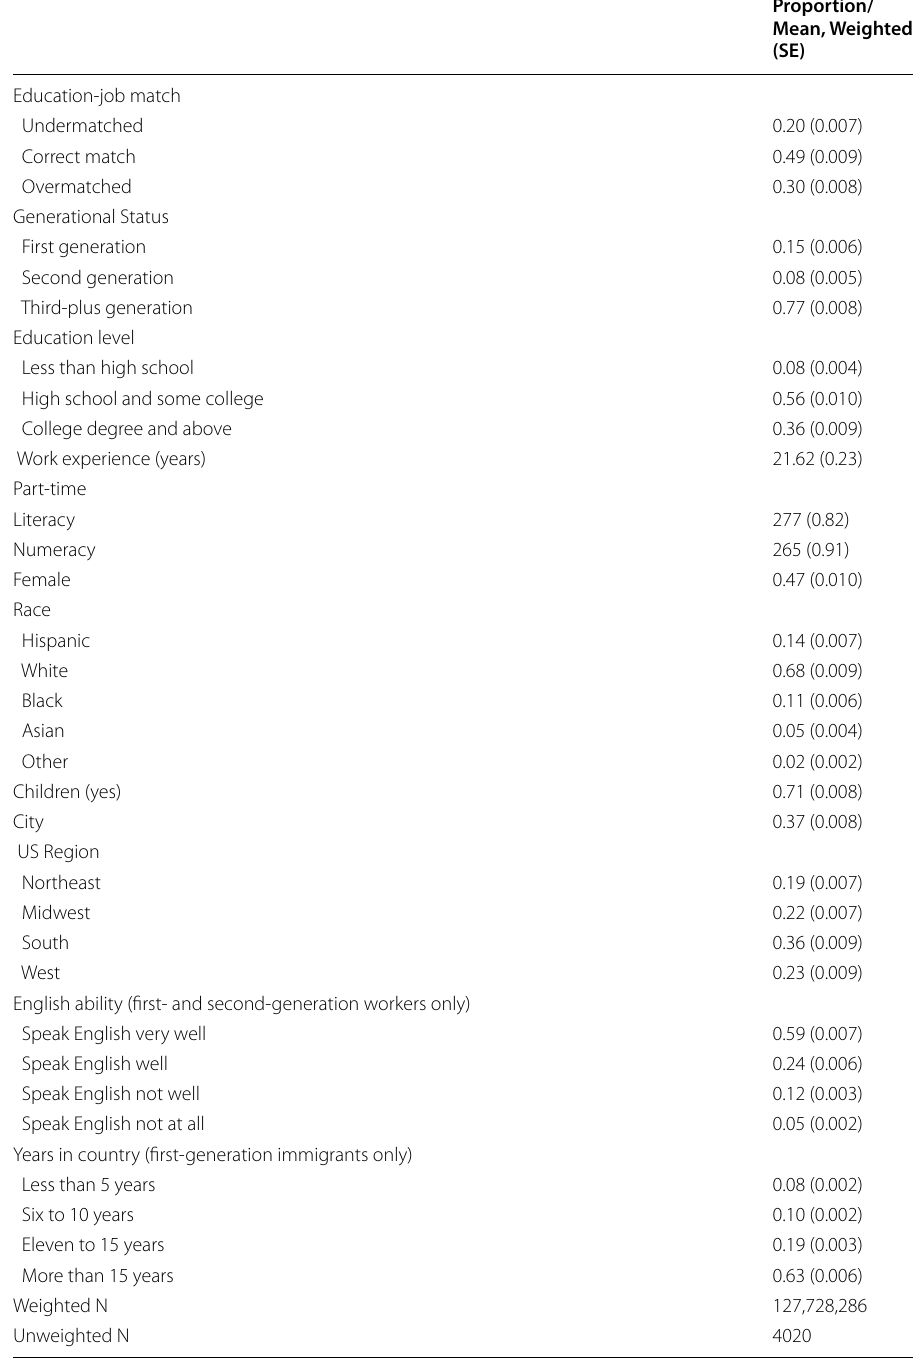
Table 1 Descriptive Statistics, Full Sample of Workers, PIAAC